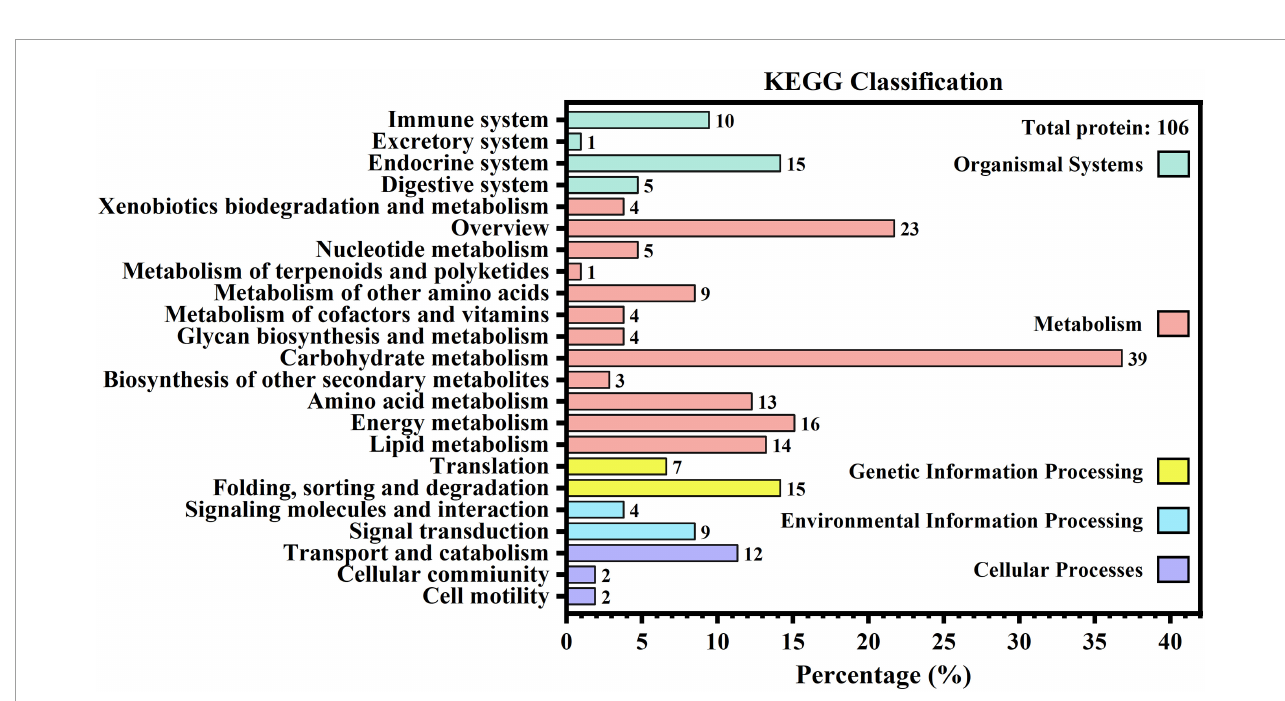
FIGURE2 Kyoto Encyclopedia of Genes and Genomes metabolic pathway of human milk caseins from Korean and Han ethnic groups in